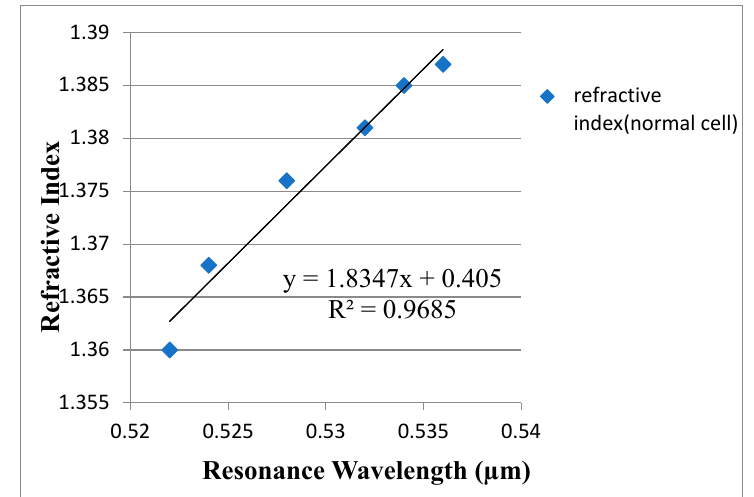
range and sensitivity to existing sensors.